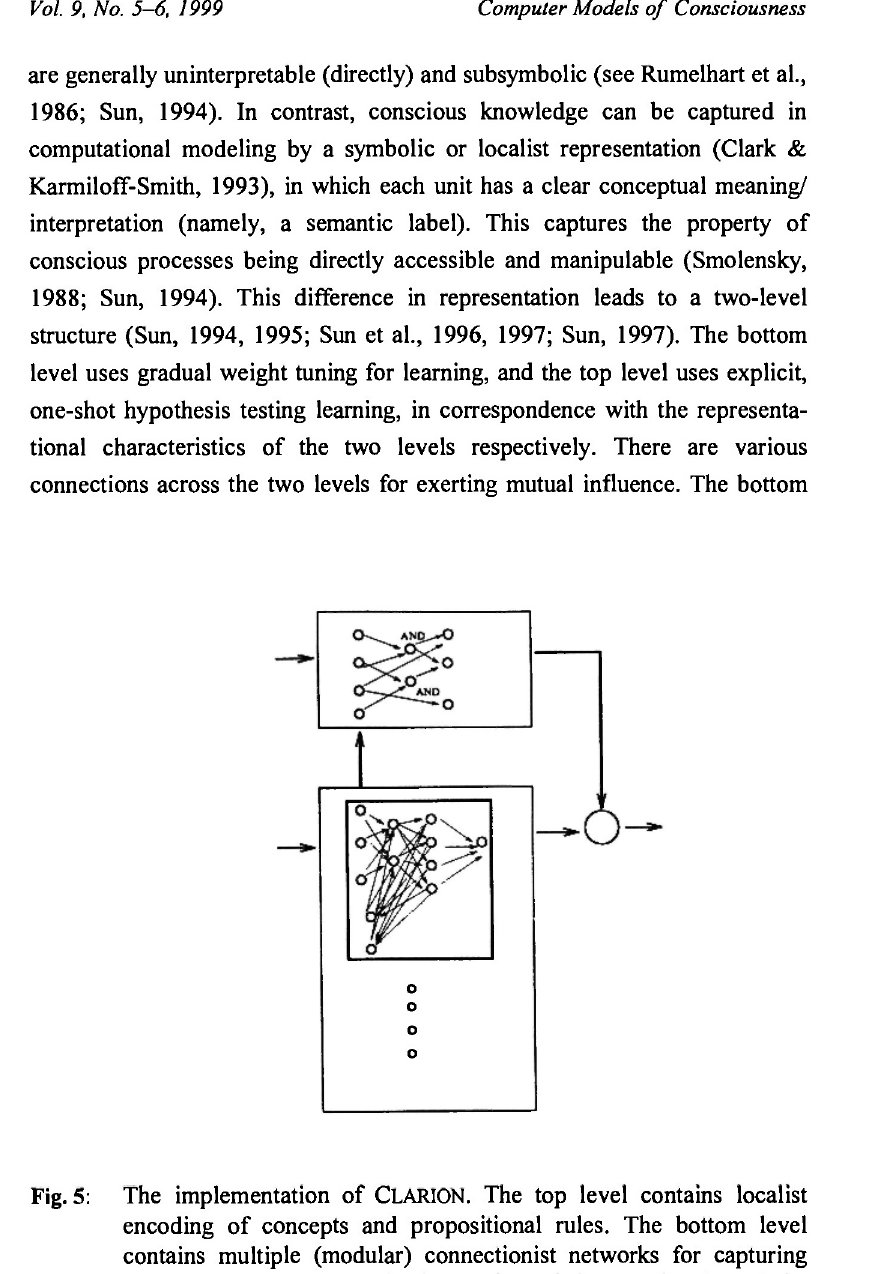
The implementation of CLARION. The top level contains localist encoding of concepts and propositional rules. The bottom level contains multiple (modular) connectionist networks for capturing unconscious processes. The interaction of the two levels and the information flows are indicated with